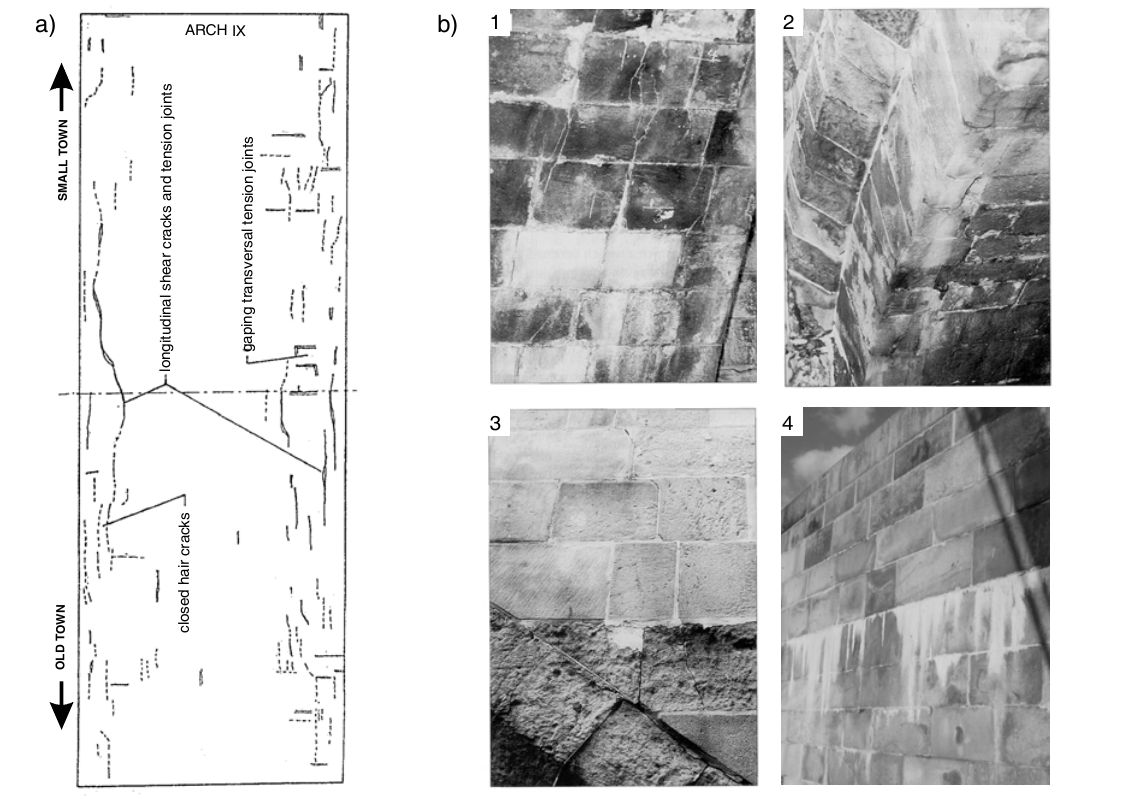
Fig 14. A scheme of tension joints and shear cracks in the face surface of vault arch IX (a); tension joints, rainwater seepage and salt sediments on the face surface of bridge vaults (1); vault masonry degradation in the area of breast wall embedment (2); cracks in the breast wall (3); washed out salts in the area of degraded bed joint (4)